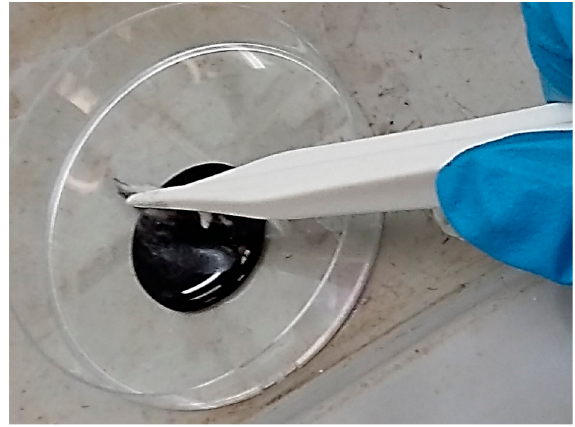
Figure 3. Photograph of the post-magnetization step involved in the preparation of the inner magnetic layer of the CA/MIONP-OAOA _CA/CA sandwiched structure.